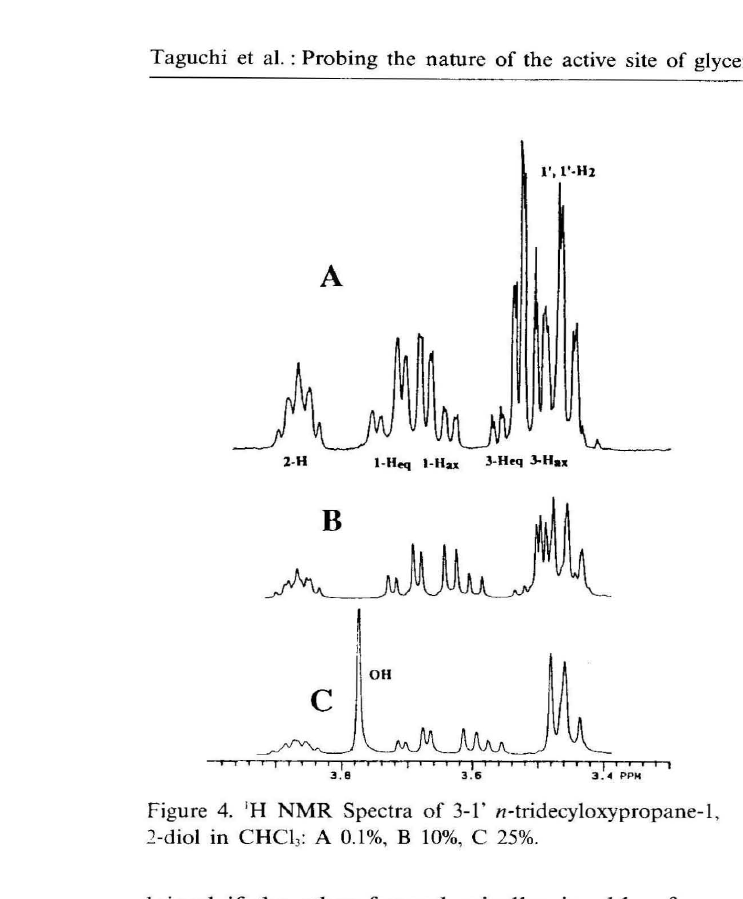
Figure 4. 'H NMR Spectra of 3-1' n-tridecyloxypropane-I, 2-diol in CHC!,: A 0.1%, B 10%, C 25%. lained if the ether formed micelles m chloroform and if its critical micelle concentration is ca